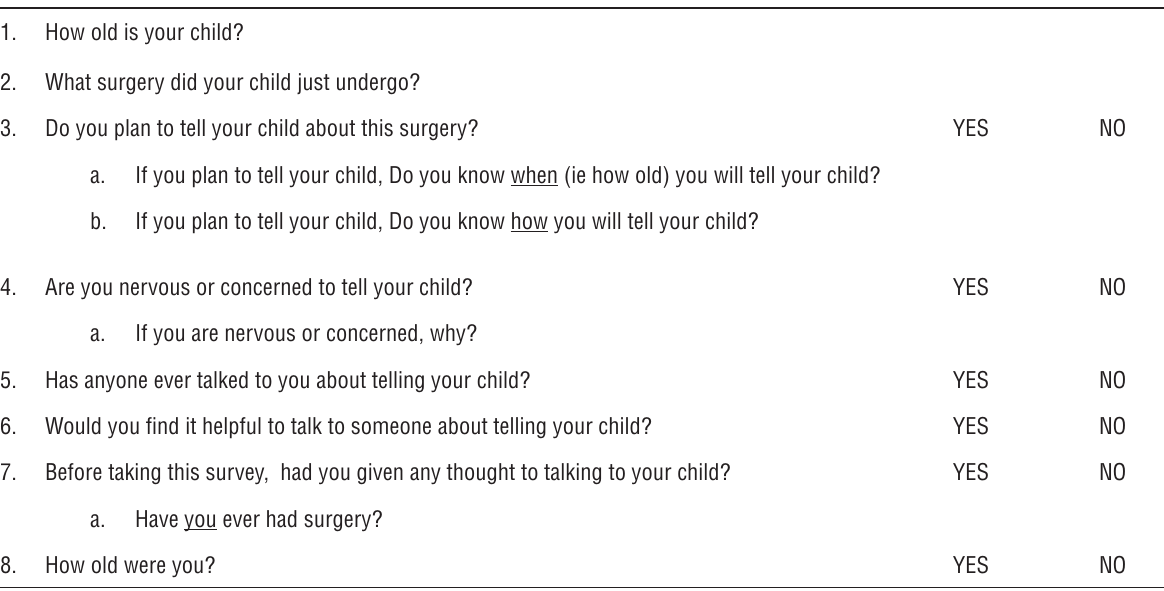
Figure 1 - Parental Disclosure of Surgery